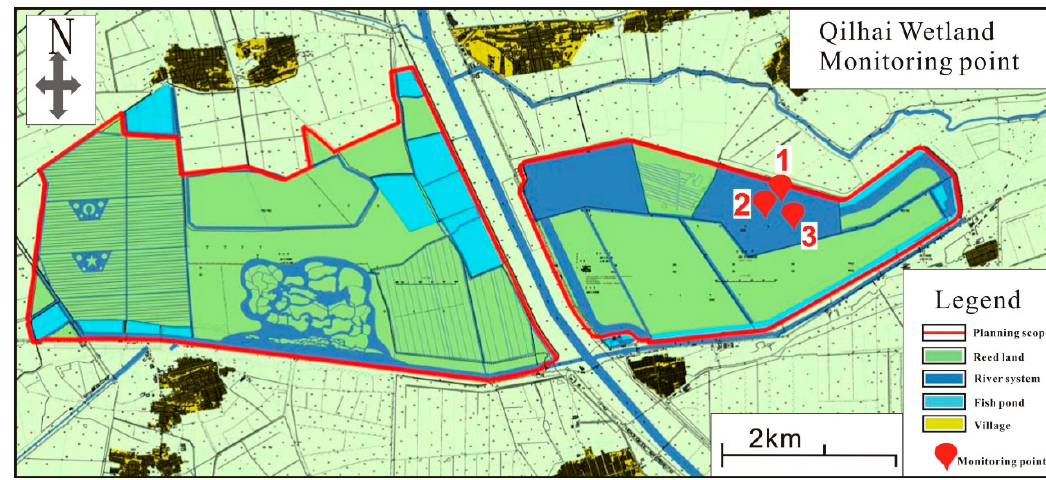
Figure 2. The map of monitoring sites in the Qilihai Wetland. Numbers 1, 2 and 3 refer to the monitoring points. Numbers marked around the monitoring points correspond to the monitoring points number in Table 1.